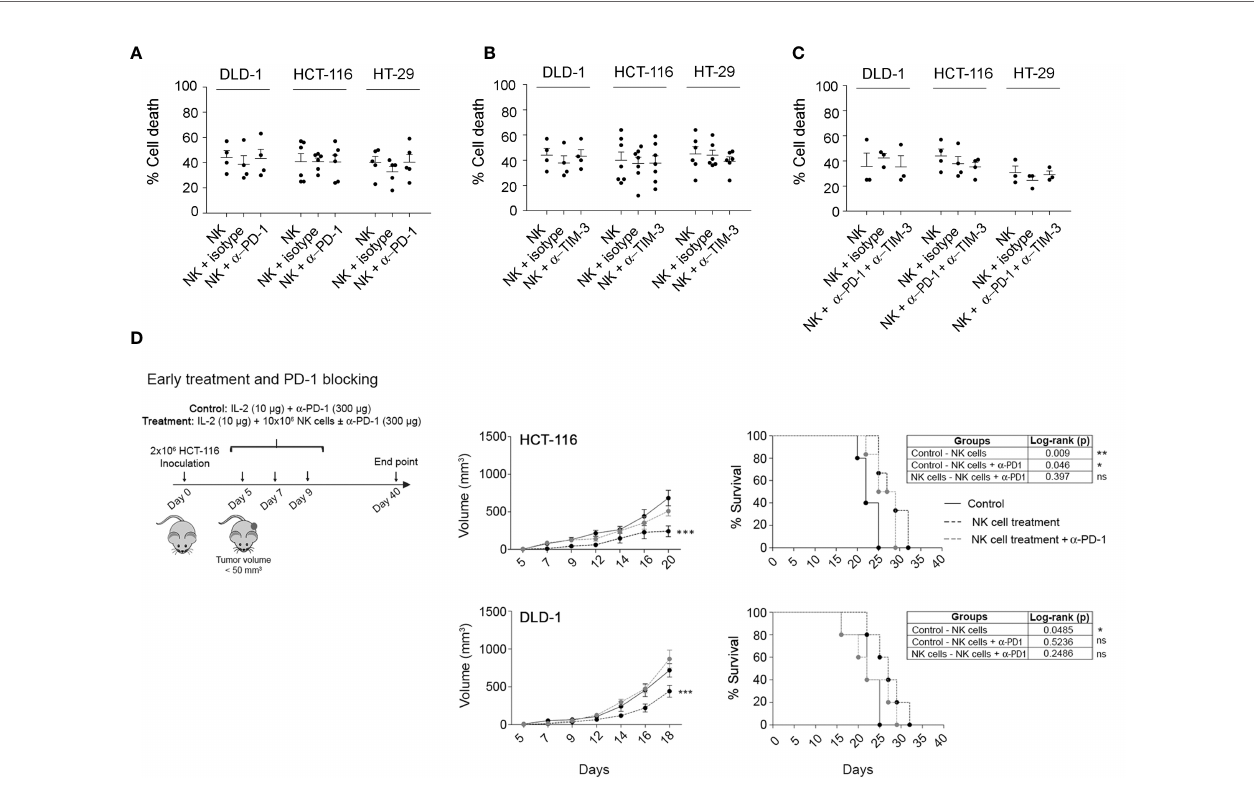
FIGURE 6 | Combination of activated NK cells and PD-1 and TIM-3 checkpoint blockers against CRC cell lines. (A – C) In vitro cytotoxicity of activated NK cells in the presence of anti-PD-1 (A) , anti-TIM-3 (B) , or both antibodies (C) . Cell death of CRC cells was analysed after 4 h co-culture (2D) with activated NK cells alone, with 20 µg/ml of pembrolizumab and/or anti-TIM-3, or 5 µg/ml of IgG isotype, at 0.5:1 (e:t) for DLD-1 or 1:1 (e:t) for HCT-116 or HT-29, by fl ow cytometry using Annexin-V/PS staining in the e-Fluor670-negative population. Data are presented as mean ± SEM from at least 3 donors after subtraction of respective controls without effector NK cells. Cell viability without NK cells was always >85%. Statistical analyses were performed by one-way ANOVA test with Bonferroni ’ s post-test. (D) Ef fi cacy of eNK cells, alone or in combination with pembrolizumab, against HCT-116 or DLD-1 xenograft tumours after an early treatment. On day 0, NSG mice were inoculated with 2 × 10 6 HCT-116 or DLD-1 cells. After 5 (early treatment), mice were i.p. inoculated with vehicle (RPMI and 10 µg/mouse IL-2), NK cells alone (10 7 NK cells and 10 µg/mouse IL-2), or NK cells with 300 µg/mouse pembrolizumab. Data are presented as mean ± SEM of 6 mice in 1 experiment. Statistical analyses to compare tumour volume curves were performed by two-way ANOVA test with Bonferroni ’ s post-test. Survival curves were analysed with Log-rank (Mantel-Cox) test. ∗ p < 0.05; ∗∗ p < 0.01; ∗∗∗ p < 0.001. NS, Not Statistically Signi fi cant. CRC, colorectal cancer; RPMI, Roswell Park Memorial